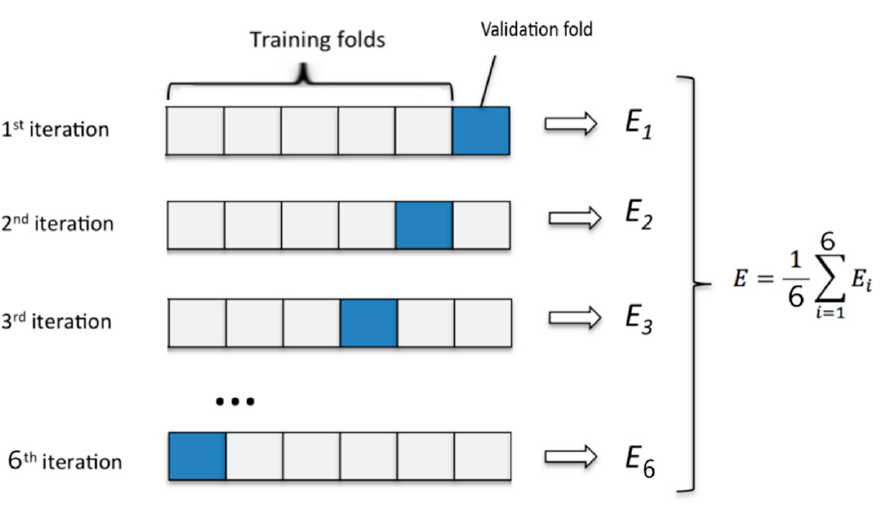
Figure 5. Distribution of training and test folds during cross validation.